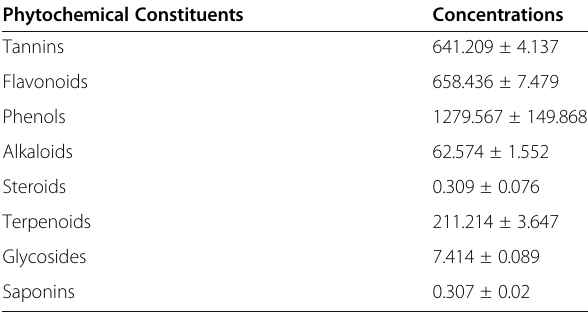
Table 1 Quantitative Phytochemical Composition of Ethanol Extract of Peltophorum pterocarpum Stem-Bark